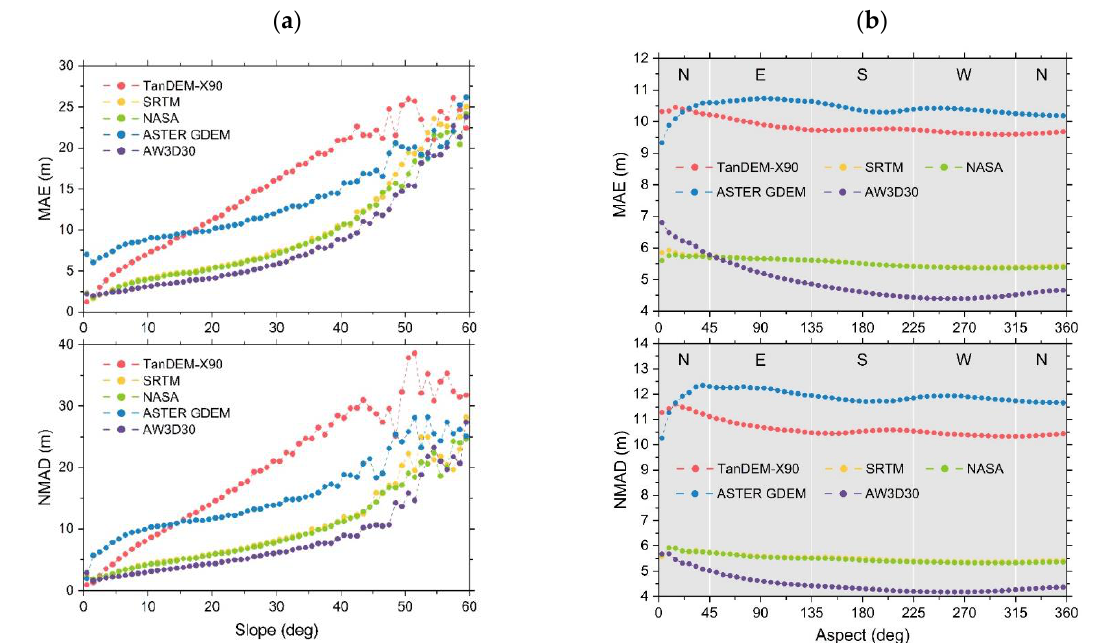
Figure 8. Relationship between quality indicators (( top ) MAE and ( bottom ) NMAD ) and ( a ) slope and ( b ) aspect.